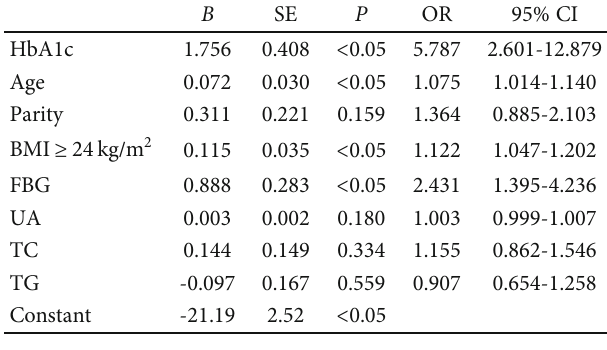
Table 1: Comparison of general clinical data between the GDM group and the NGDM group ( (cid:1) x ± s ).